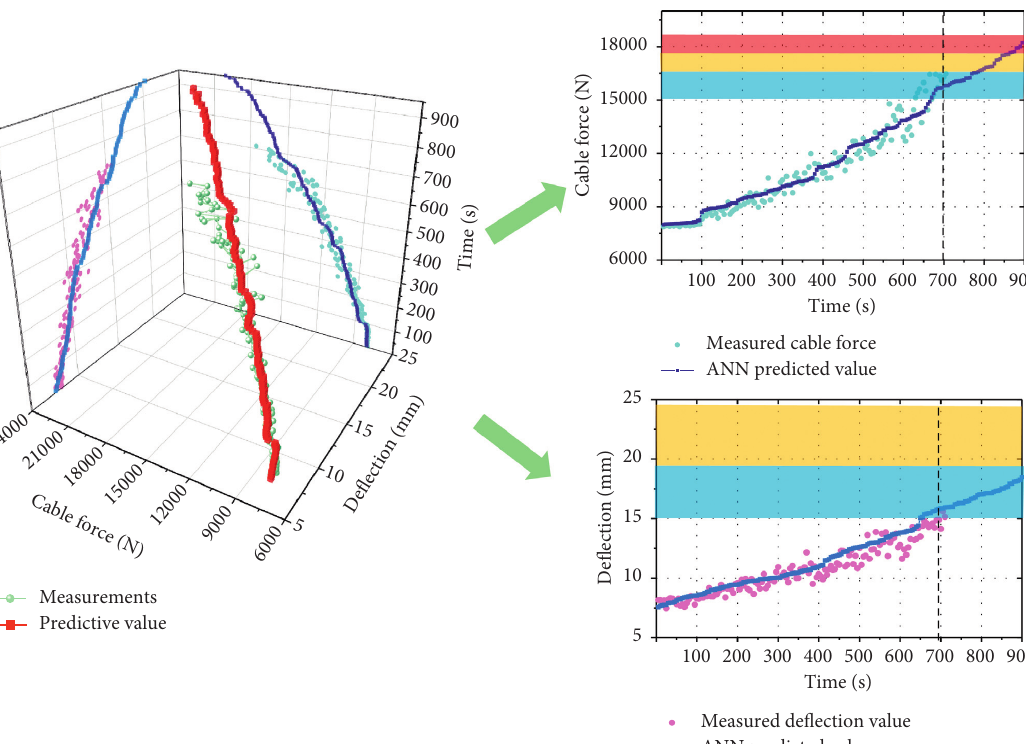
Figure 17: Effect drawing of monitoring and early warning